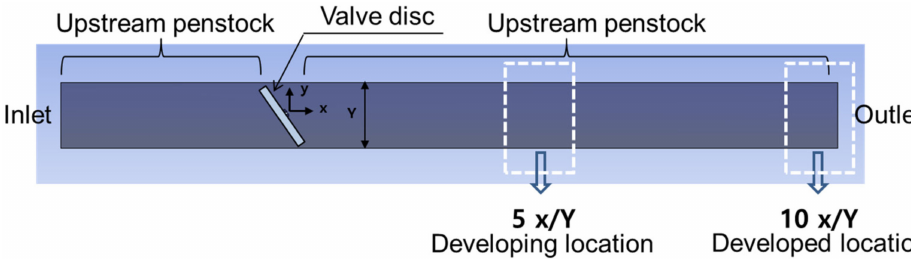
Figure 1. Illustrations of calculation region for the cross section of a single butterfly valve.